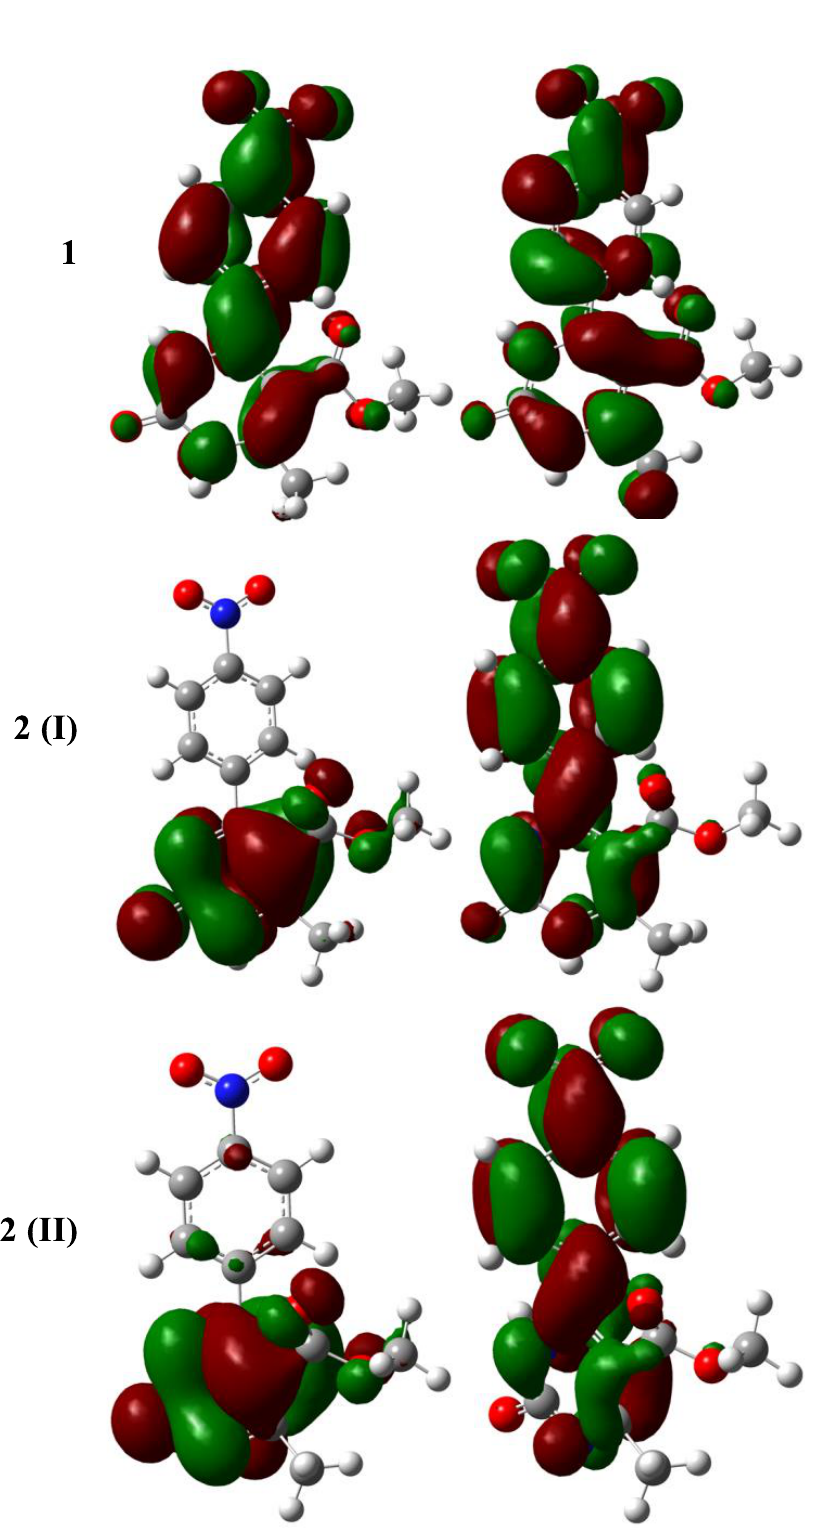
Figure 9. Contour diagram of frontier molecular orbitals.